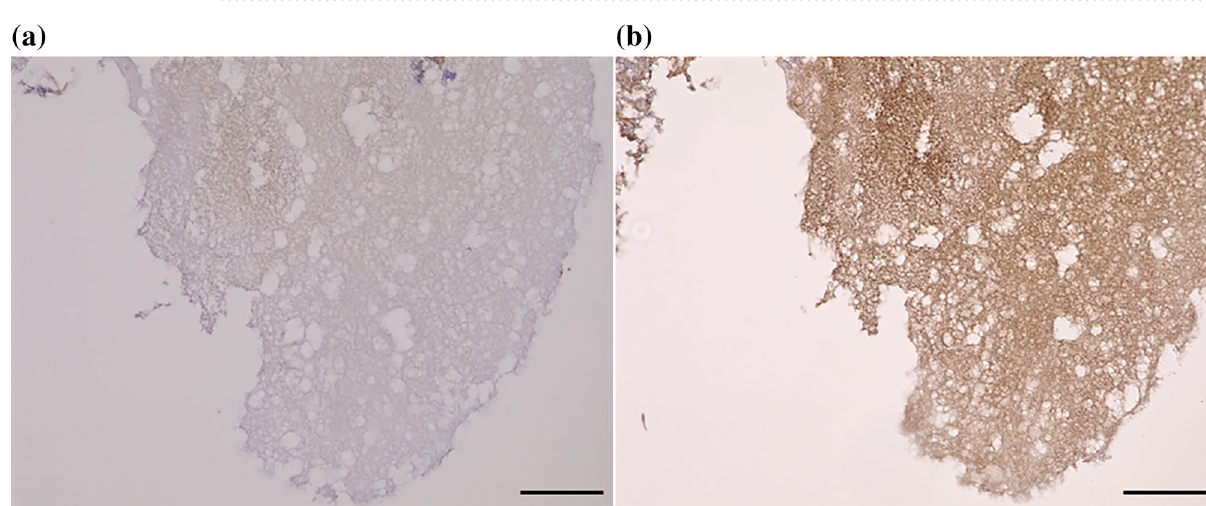
Figure 5. Location of Protein S in the components of a cystoid lesion with diabetic macular edema. The component of cystoid lesion with DME was stained with anti-hPS antibody. No staining was observed in the control nonspecific IgG ( a ). PS was identified inside the component of cystoid lesion ( b ). DME, diabetic macular edema; PS, protein-S. Bar: 100